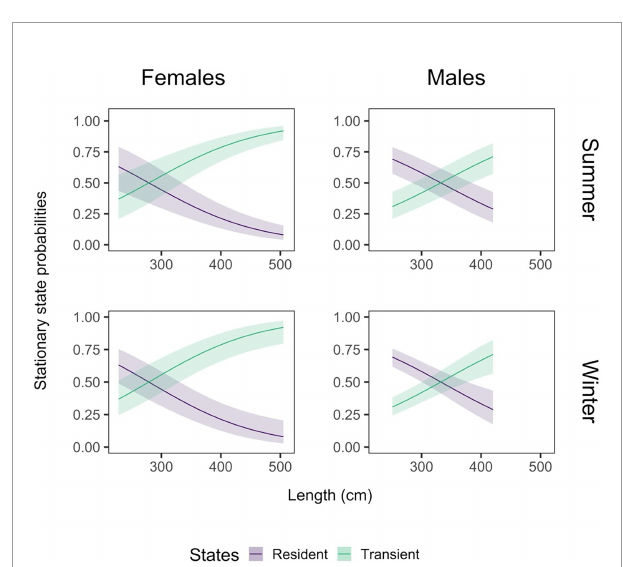
FIGURE 6 | The effect of total length on the probability of fi nding a shark in a given state. The effect of length is shown here by sex (females: left column, males: right column) and season (summer: top row, winter: bottom row). We de fi ne seasonality according to the peak of mature transient movement and the trough of immature resident movement, as seen in Figure 5 . Therefore, we de fi ne summer as day 40 of the year (9 February) and winter as day 220 (8 August). The shading around the state line represents the 95% con fi dence interval around the mean effect.